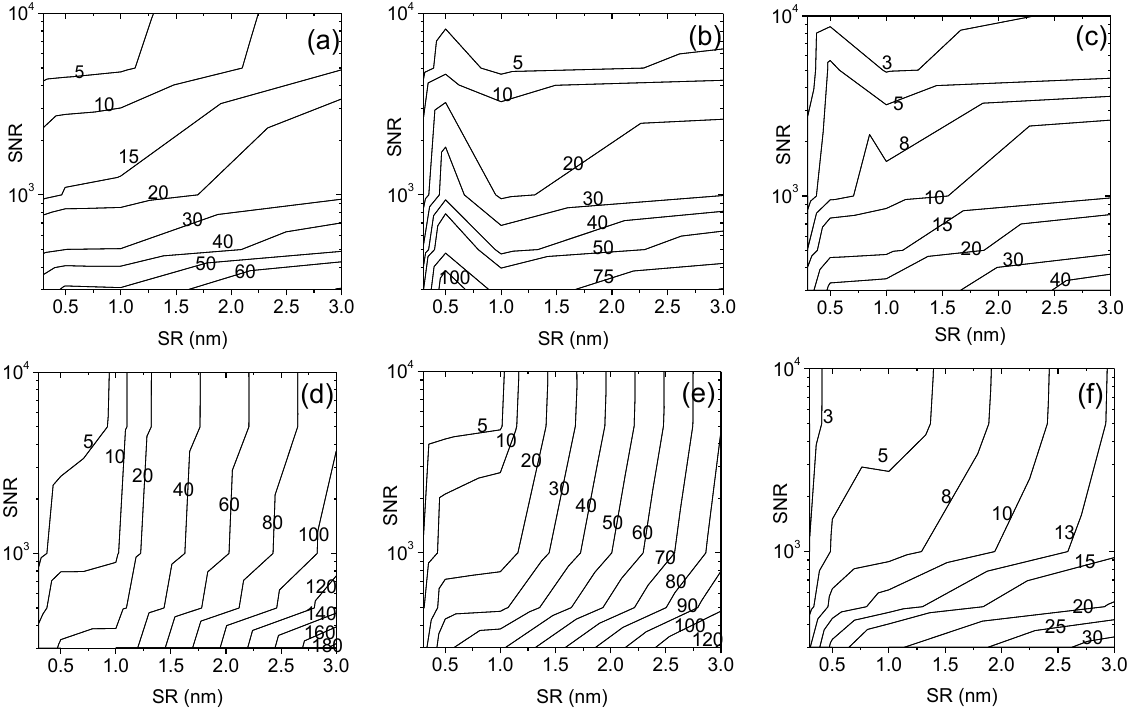
Figure 8. Contours of the RRMSE (%) in the SIF at the O 2 -A ( a–c ) and O 2 -B ( d–f ) bands retrieved by the 3FLD ( left ), iFLD ( middle ) and F-SFM ( right ) algorithms using simulated test datasets with different SRs and